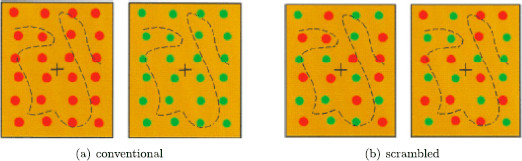
Learned images in colored-dot experiments of [14]